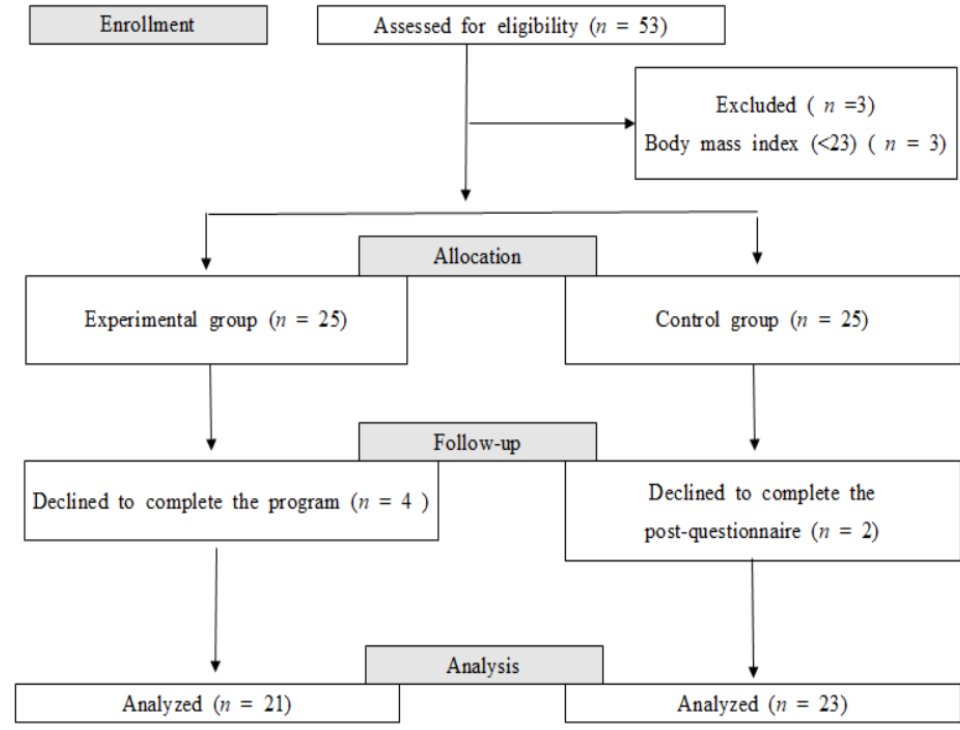
Figure 1. Flow diagram of participant enrollment in the study.